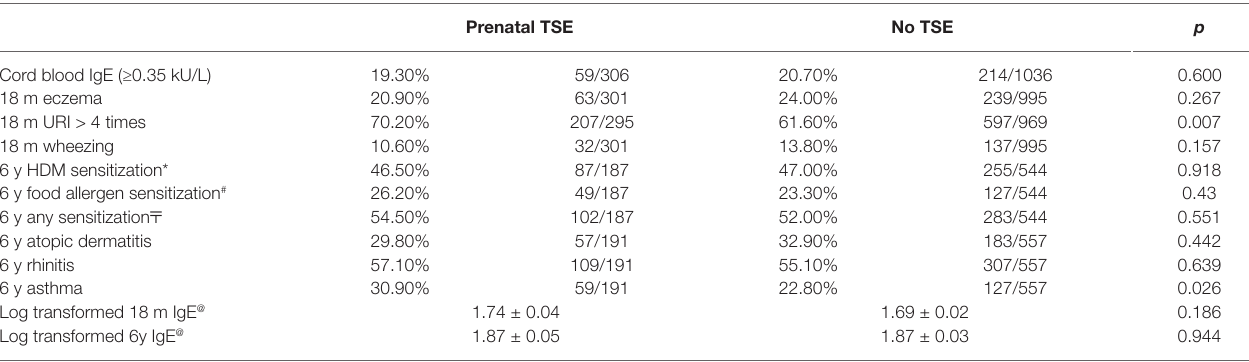
TABLE 1 | Allergic sensitization and diseases in children with and without prenatal PTS. Prenatal TSE No